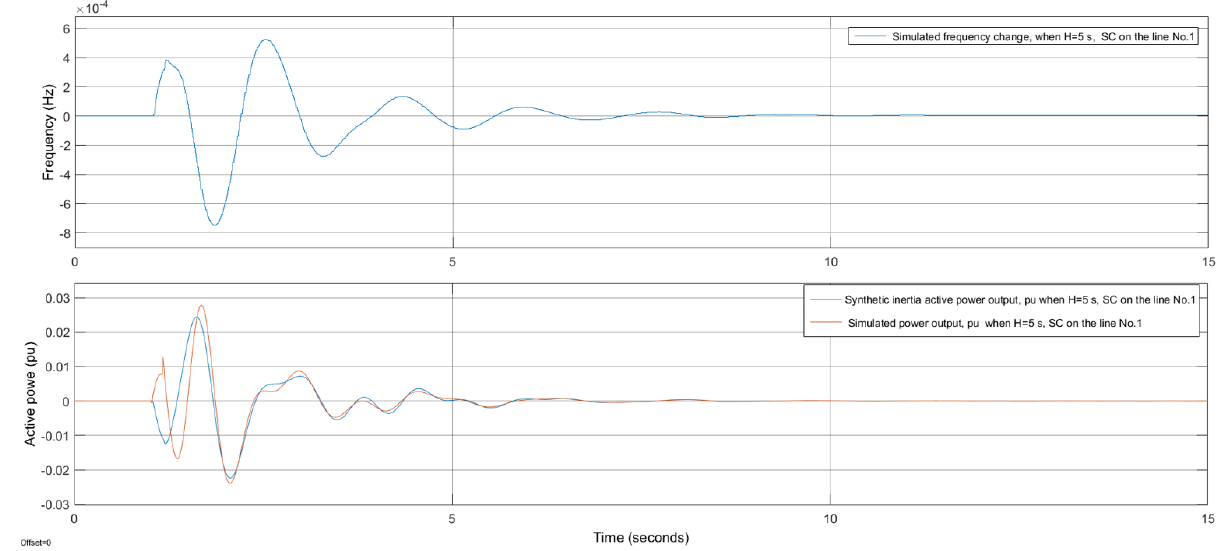
Figure 8. Comparison of active power outputs of the SI algorithm and simulated power output, when H = 5 s and 3ph short circuit (SC) in the overhead line is far away (in the middle of power system) from the generating source with the SI algorithm.